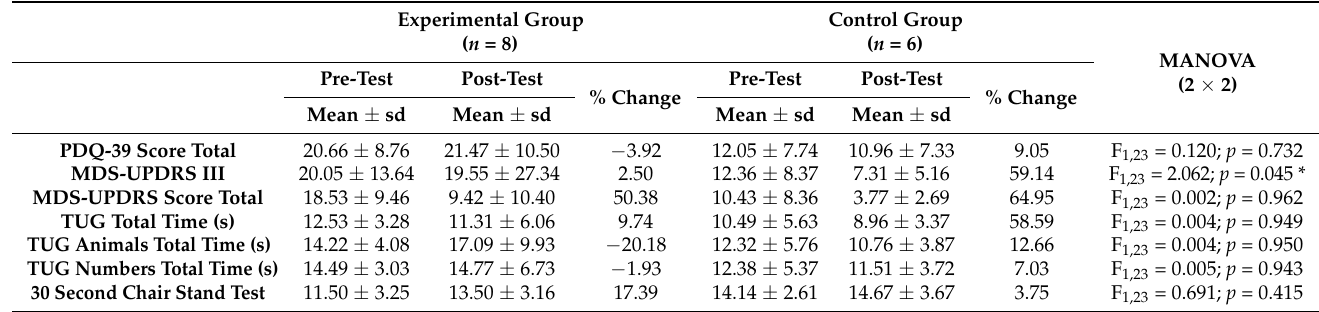
Table 3. Results on primary outcomes pre- and post-intervention.